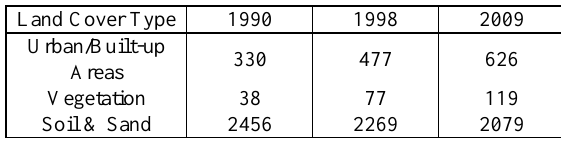
Table 3. Area in Sq. Km of the land covers from